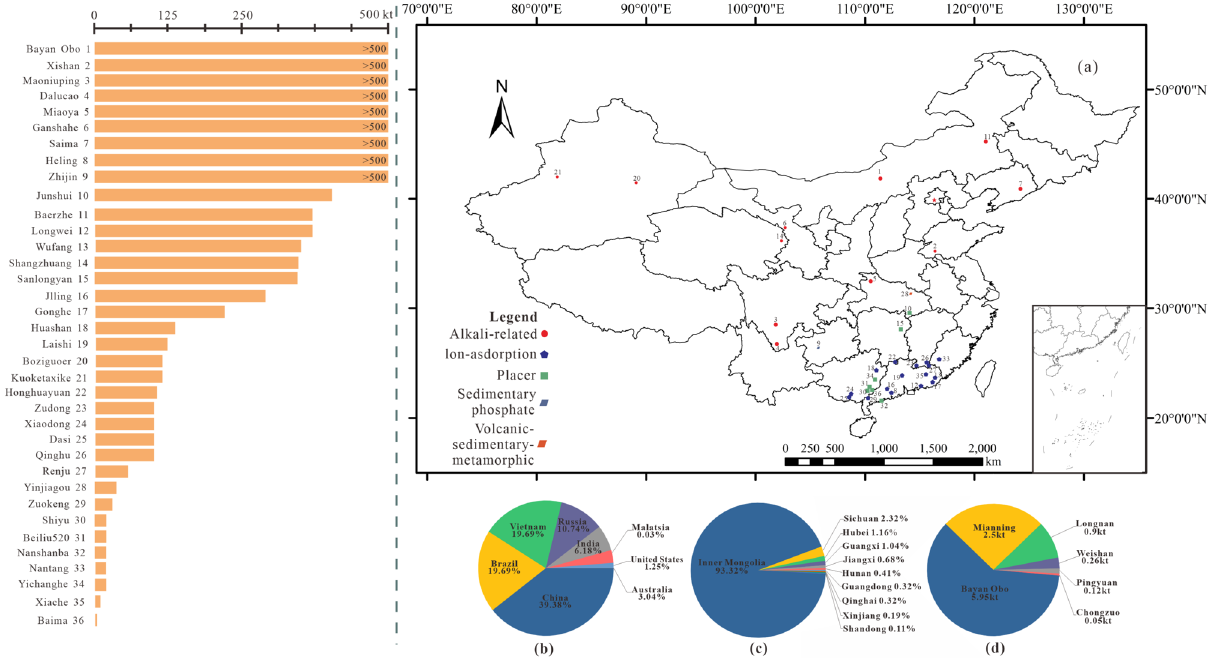
Figure 1. Distribution of rare earth mines in China. ( a ) 36 rare earth mine types and reserves; ( b ) reserves of rare earths in major countries in the world; ( c ) reserves of rare earths in major provinces in China; ( d ) annual mining capacity of rare earths in major mining areas in